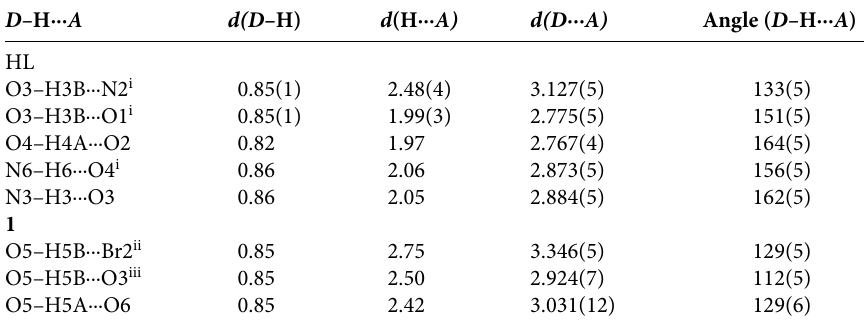
Table 3. Hydrogen bond distances (Å) and bond angles (°) for the compounds